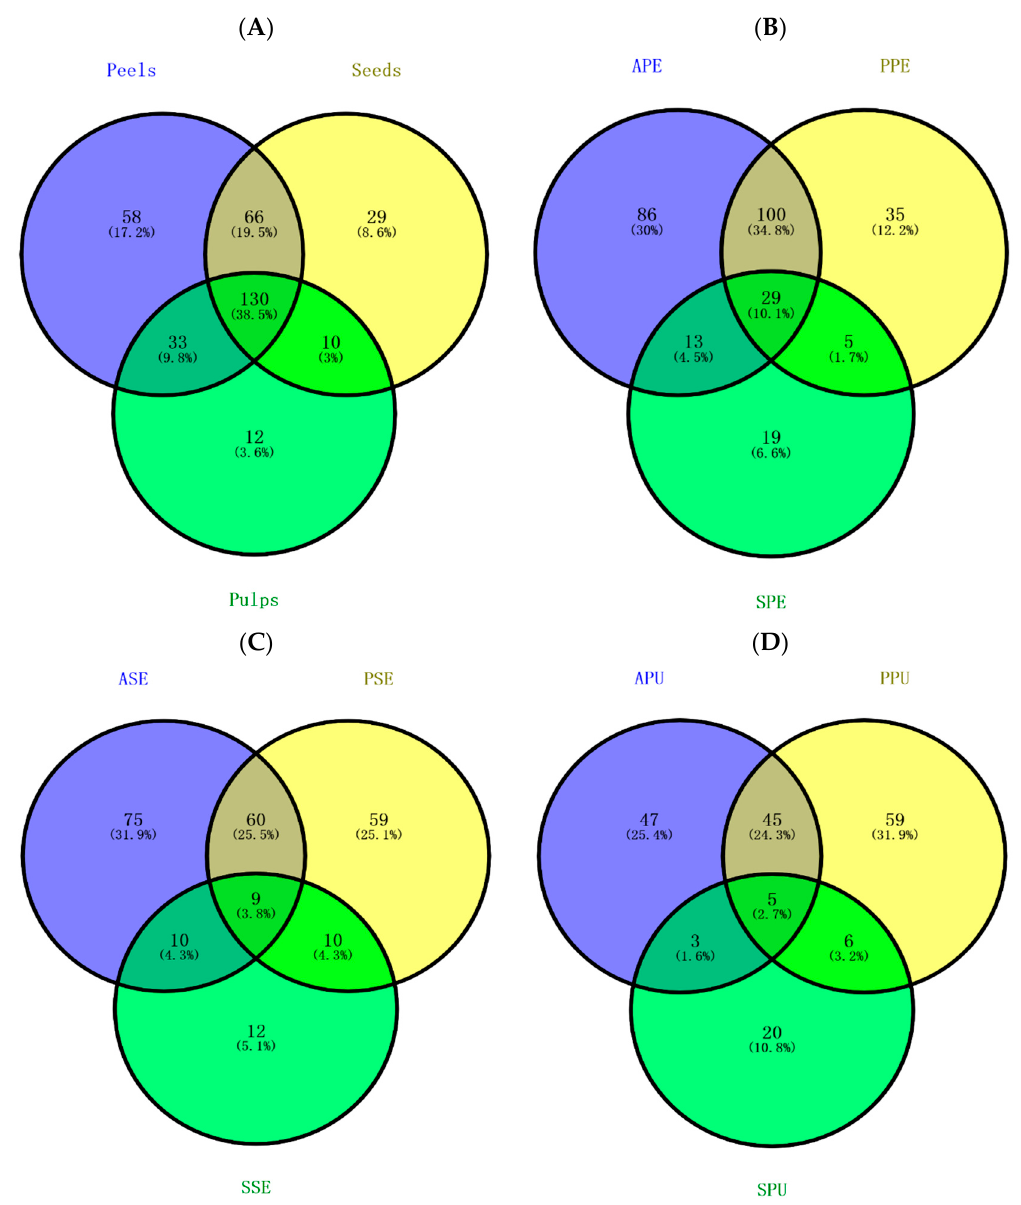
Figure 2. Venn diagram of the distribution of phenolic compounds in various custard apple portions, including peel, seeds and pulp. The relations of ( A ) total phenolic compounds present in three portions of custard apple, ( B ) phenolic compounds in peels, ( C ) phenolic compounds in seeds and ( D ) phenolic compounds in pulps.